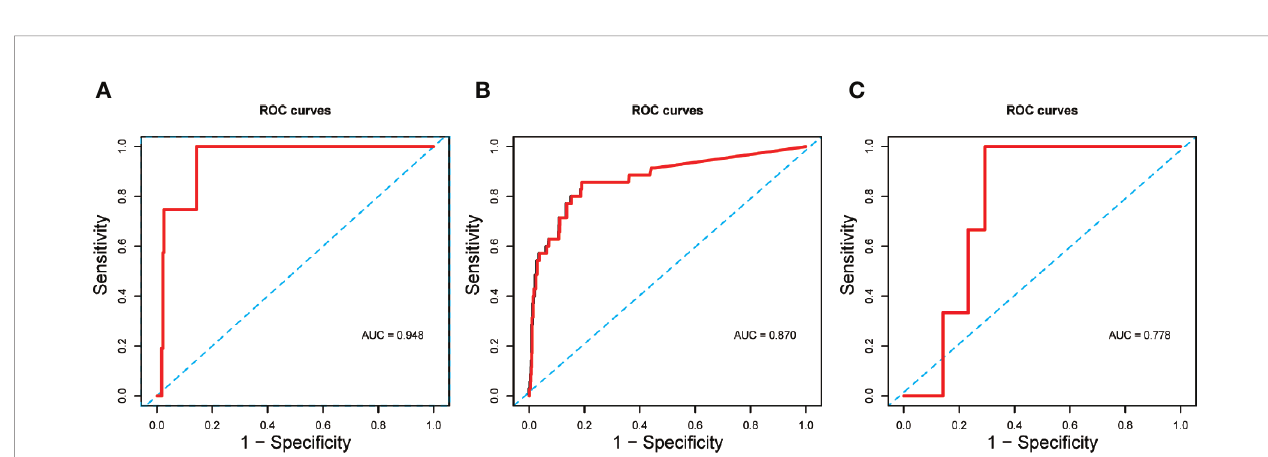
FIGURE 3 | (A) ROC curve assessed the predictive capability of elevated IL-6 for death; (B) ROC curve assessed the predictive capability of elevated IL-6 for disease severity; (C) ROC curve assessed the predictive capability of elevated IL-6 for CT scores.